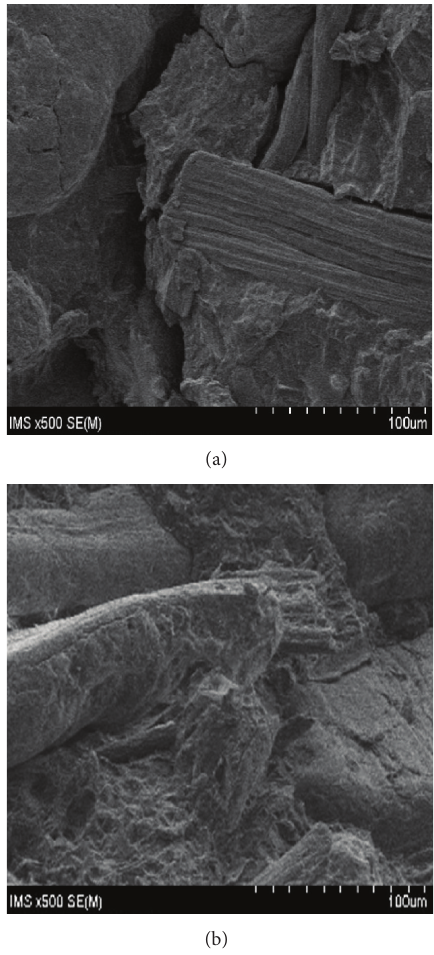
Figure 8: SEM images of (a) PP/RHF and (b) PP/RHF/PP-g-MA 4wt%.